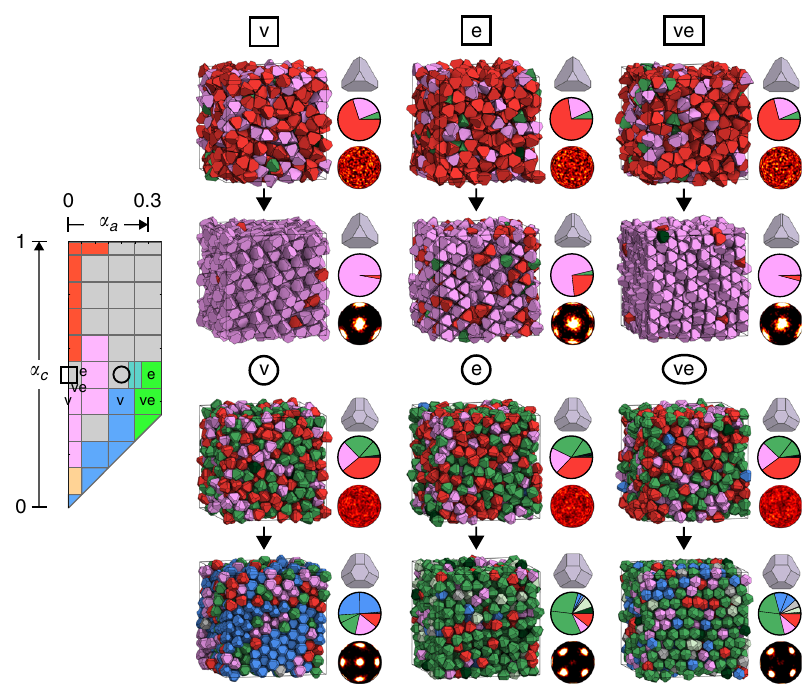
Fig. 5 Alchemical Monte Carlo simulations of would-be glass-formers. Would-be glass-formers escape their identity crisis and crystallize when allowed to explore their surrounding shape space via alchemical Monte Carlo simulation. Squares indicate simulations at the glass-forming state point ( α a , α c ) = (0, 0.5), while circles correspond to simulations at ( α a , α c ) = (0.2, 0.5). Empty symbols overlaid above the shape space indicate system position at the start of Alch-MC sampling, and letters indicate system position after 20 – 30 million MC sweeps of vertex truncation (v), edge truncation (e), or both vertex and edge truncation (ve) sampling. System snapshots, particle shapes, pie charts of pairwise motif fractions, and bond-order diagrams 31 are shown for initial and fi nal frames of each Alch-MC simulation. Pie chart wedges are colored according to the motifs identi fi ed in Fig. 3. Wedges colored gray represent (connection type, θ ) regimes that were not identi fi ed with any crystal structure. Pie chart wedges colored identically represent motifs characteristic of the same crystal structure that differ only by connection type. In those cases, the motif with face connection is always drawn second, proceeding in a counter- clockwise fashion. The hexagonal bond-order diagram resulting from edge Alch-MC sampling at ( α a , α c ) = (0, 0.5) is a consequence of wurtzite-like structural motifs due to the presence of stacking faults in the system. Crystalline structures resulting from edge and vertex-edge Alch-MC sampling at ( α a , α = (0.2, 0.5) contain multiple grains and stacking faults; associated bond-order diagrams show the local environment of particles in just a single grain. In c ) all cases shown, disordered dense fl uids avoid vitri fi cation and instead form crystals dominated by a single pairwise